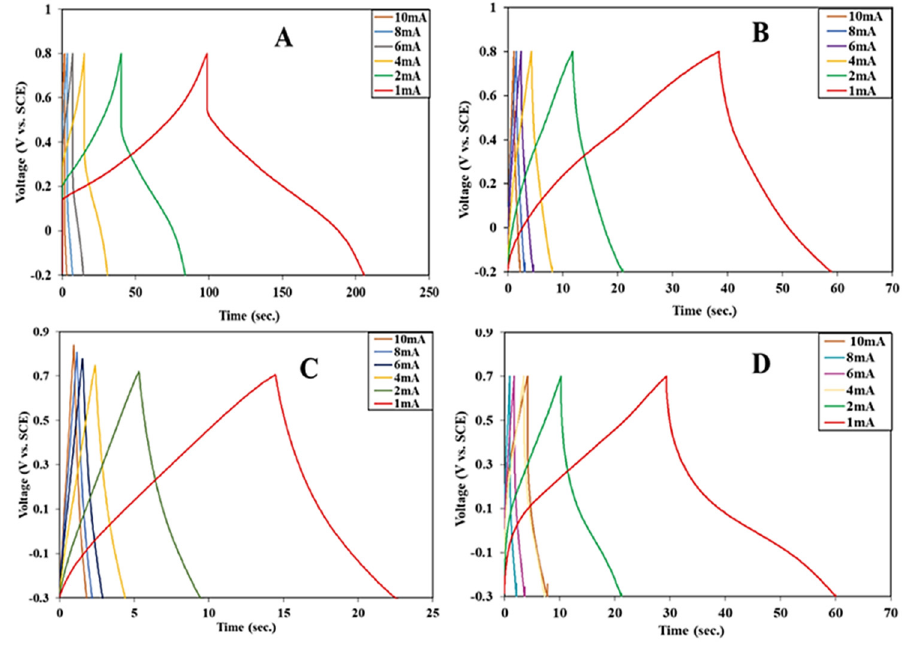
Figure 6. GCD cycles of ( A ) PANI, ( B ) rGO, ( C ) α -MnO 2 /PANI and ( D ) α -MnO 2 /PANI/rGO.